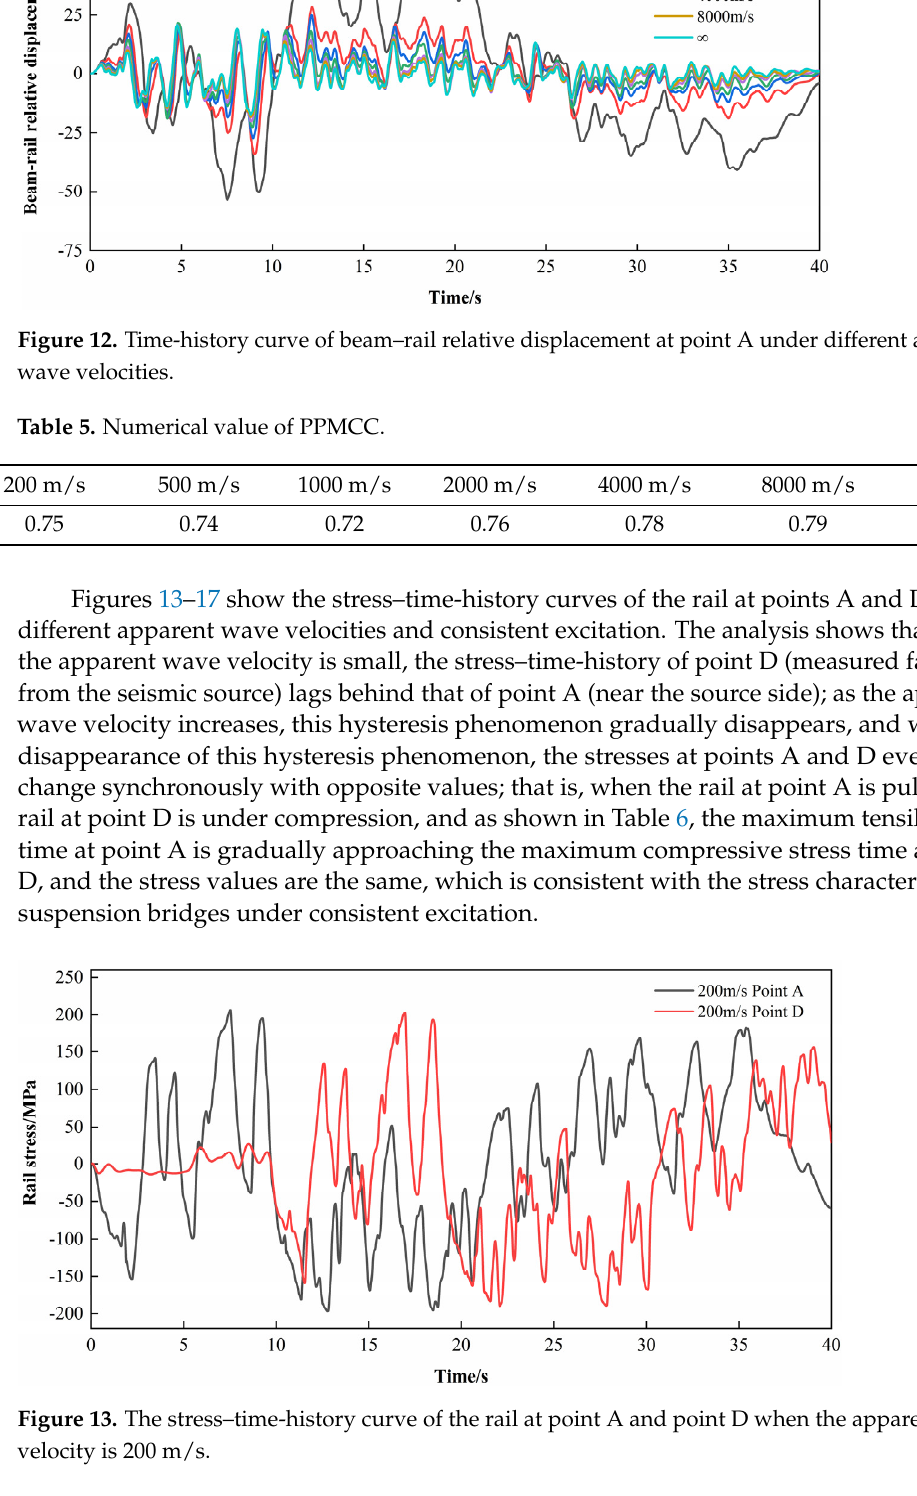
Figure 11. Time-history curve of rail stress at point A under different apparent wave velocities.